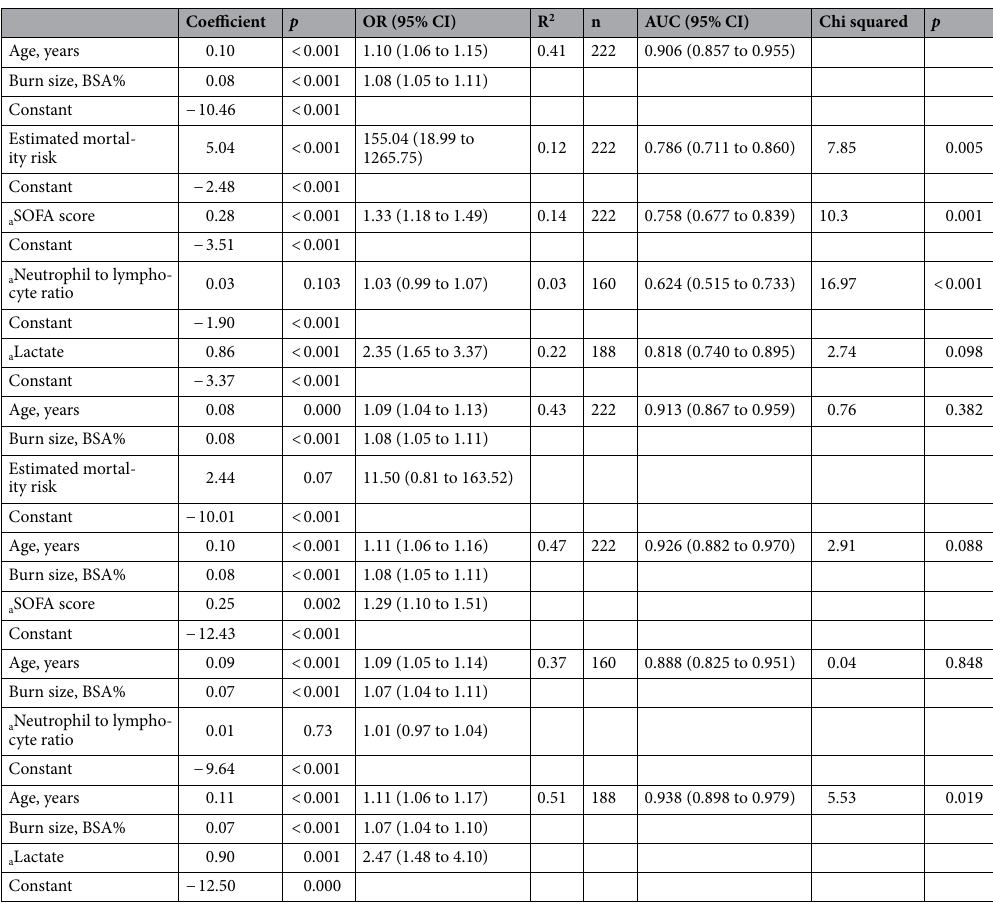
Table 2. Nine models for mortality, eight are compared to the first model (age and burn size). Logistic regression, burn centre non survivors coded 1, survivors 0. R 2 is the Pseudo R 2 . AUC, area under the curve (under the receiver operating characteristic curve). Chi squared p is calculated pairwise on the difference between the first model (age and burn size) and each of the other models (no correction). BSA, body surface area. a = admission. SOFA score, Sequential organ failure assessment